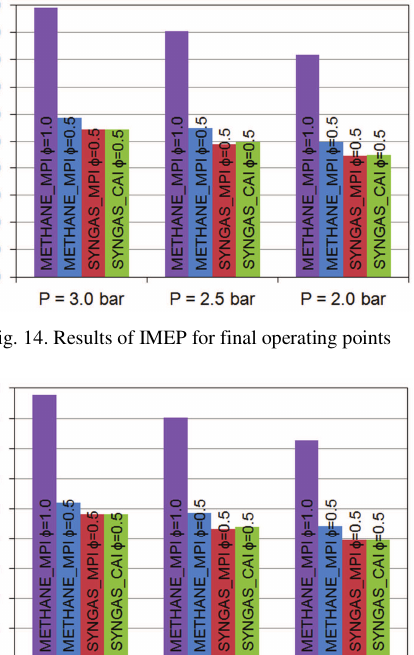
Fig. 18. Results of HC emission for final operating